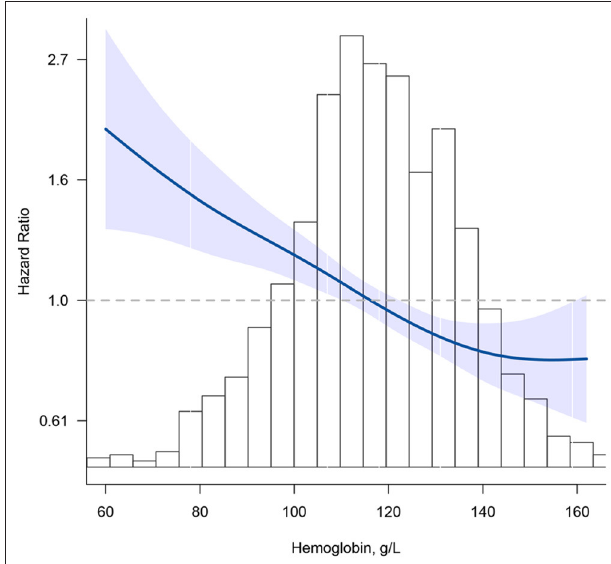
FIGURE 1 | Association between hemoglobin (Hb) and all-cause mortality. Hazard ratios are indicated by blue solid lines and 95% CIs by shaded areas. Histogram represents the distribution of Hb. Model was adjusted for age, sex, education, marital status, ethnicity, current smoker, current drinker, body mass index, cognitive impairment, albumin, high-sensitivity C-reactive protein, and chronic conditions (hypertension, diabetes mellitus, and chronic kidney disease) using restrict cubic splines.